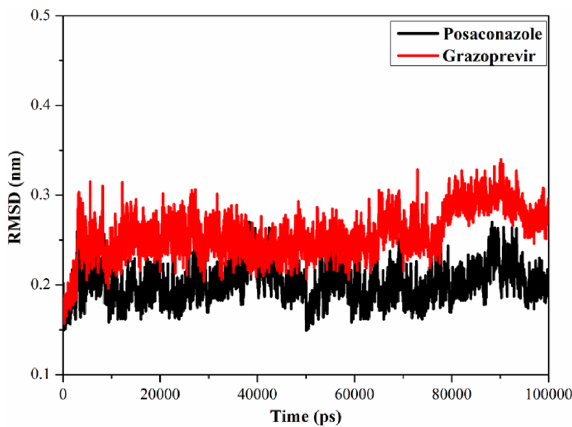
Figure 6. Root mean square deviation (RMSD) of the backbone atoms from the initial structure for posaconazole (in black) and grazoprevir (in red) with the SARS-CoV-2 helicase over 100 ns MD